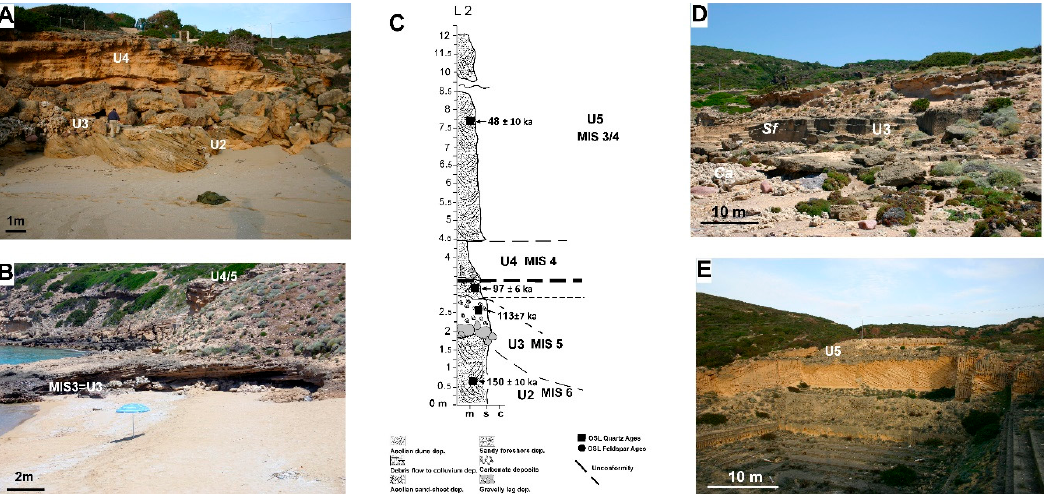
Figure 5. Burantino area. A ) Outcropping sedimentary units. B ) Full view of the prograding beach system associated to Unit 3 (U3) and referred to MIS5. Note the similarity with the modern